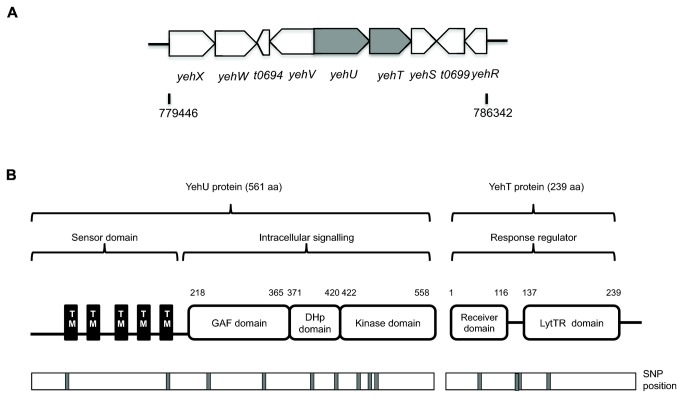
A The yehUT operon with surrounding genes.The operon is 2349bp in length and located between 782210 to 784611 bp in S. Typhi Ty2 (Accession number AE014613) and between c2251460 to c253861 bp in S. Typhimurium SL1344 (Accession number FQ312003). The surrounding genes include yehV, t0694, yehW, yehX (upstream of yehU) and yehS, t0699 and yehR (downstream from yehT). B The domain organisation of the YehU and YehT proteins. YehU protein comprises of five transmembrane (TM) alpha helical segments predicted using TMHMM webserver [17]. The intracellular signalling component consists of a GAF domain, a DHp (dimerization/histidine-containing phosphotransfer) domain that is connected to an ATP (adenosine triphosphate)-dependent Kinase domain. YehT protein consists of a Receiver domain and a LyTR-homologous DNA binding domain [16]. The phosphorylation sites are indicated (H, Histidine; D, Aspartate). The SNP positions identified in yehU and yehT genes are indicated below the proteins by grey boxes [10].